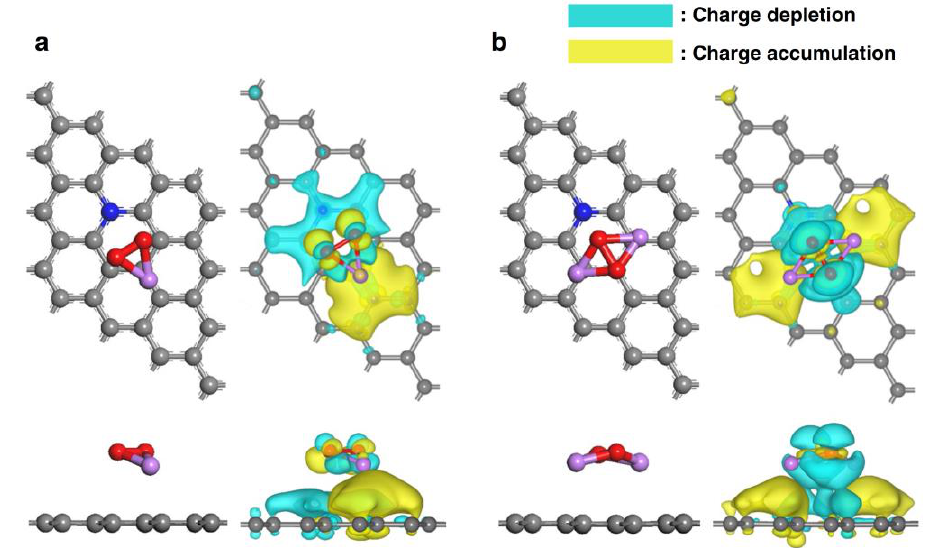
Figure 44. Plots of charge density difference ( a ) for N-doped graphene/LiO 2 and ( b ) for N-doped graphene/Li 2 O 2 . Reproduced from Lee et al. [94] with permission of Springer.